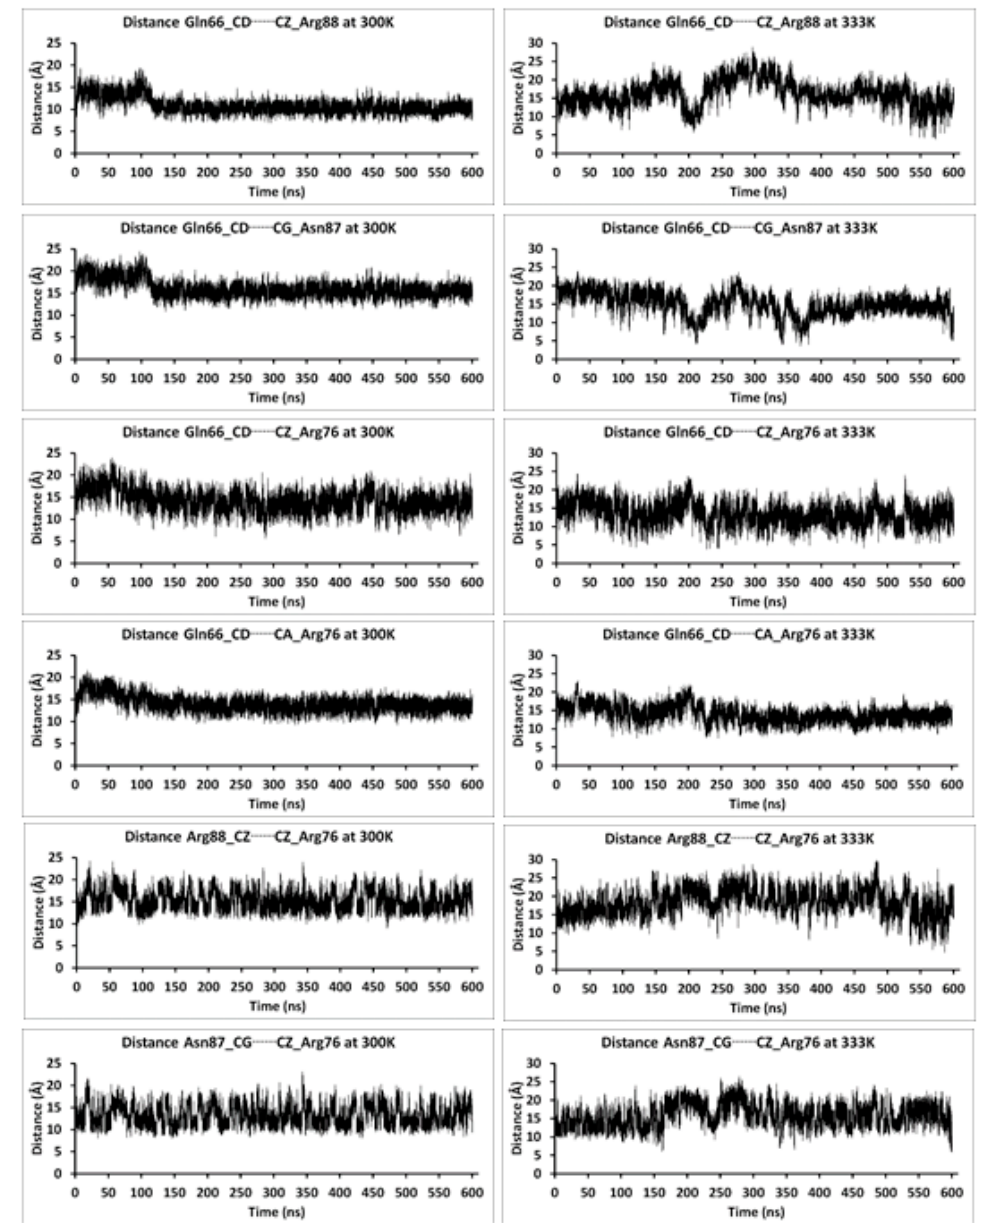
Figure 4. Selected measured distances (Angstrom) between Gln66-Arg88, Gln66-Asn87, Gln66-Arg76, Arg88-Arg76, and Asn87-Arg76 over the course of the continuous 600.5 ns MD simulations of P450-TT enzyme performed at 300 K and 333 K.